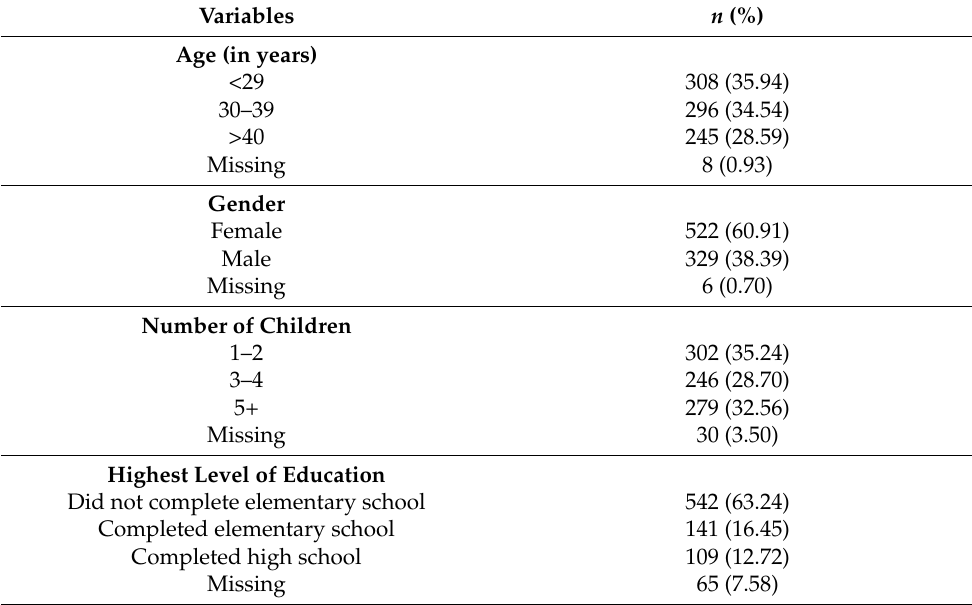
Table 1. Demographic Characteristics N =